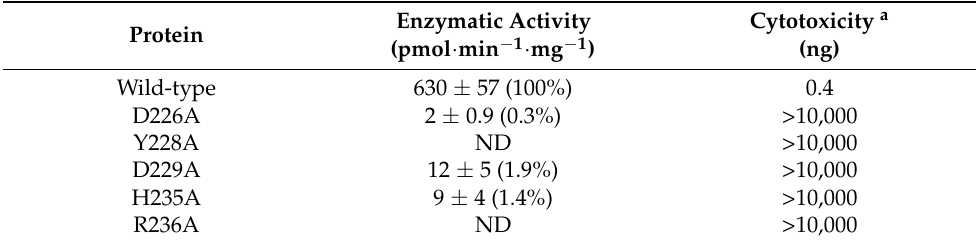
Table 1. In vitro and in vivo activity of different mutants of ColM. ND, not detected up to 10 µ g of purified protein (after [26]).